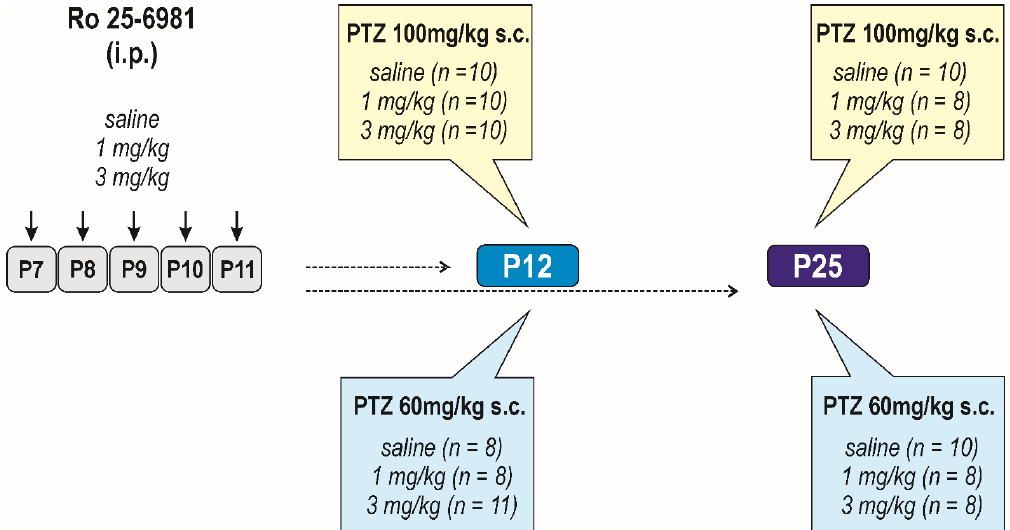
Figure 1. Design/time diagram of seizure susceptibility assessment. Scheme of Ro25-6981 administration and used doses are shown in the left part of the diagram. Ro25-6981, dissolved in saline, was administered in two doses, 1 and/or 3 mg/kg i.p. for five consecutive days (P7–P11). Controls received saline in corresponding volume instead of Ro25-6981 solution. Seizure susceptibility was assessed in two age groups, P12 and P25 animals; i.e., 1 and 14 days after treatment cessation. Seizures were induced with PTZ in either dose 100 and/or 60 mg/kg s.c. only once; i.e., separate groups of animals were used for each age and dose group of animals.